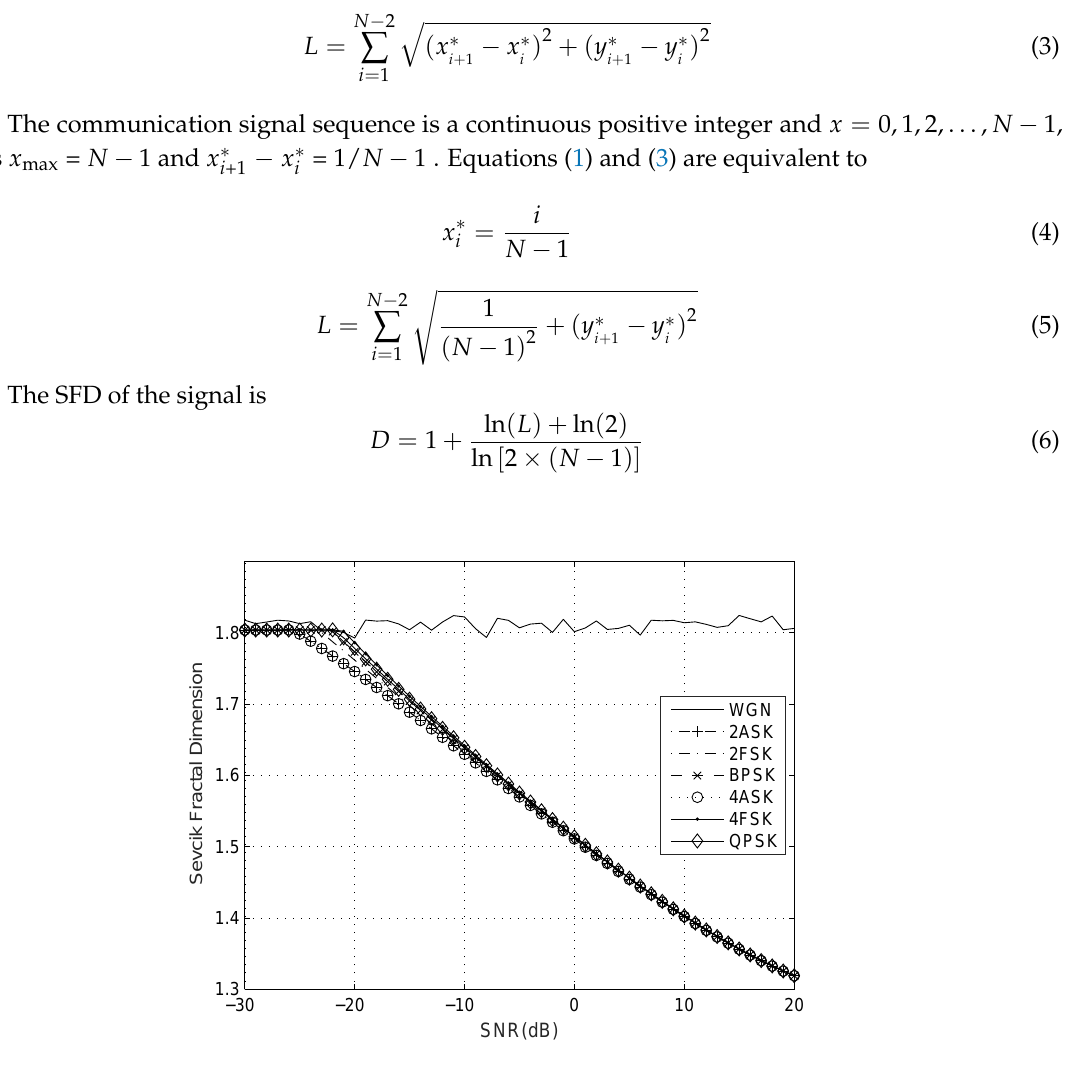
Figure 1. Sevcik fractal dimension of different kinds of signals. ASK: amplitude shift keying; FSK: frequency shift keying; QPSK: quadrature phase shift keying; WGN: white Gaussian